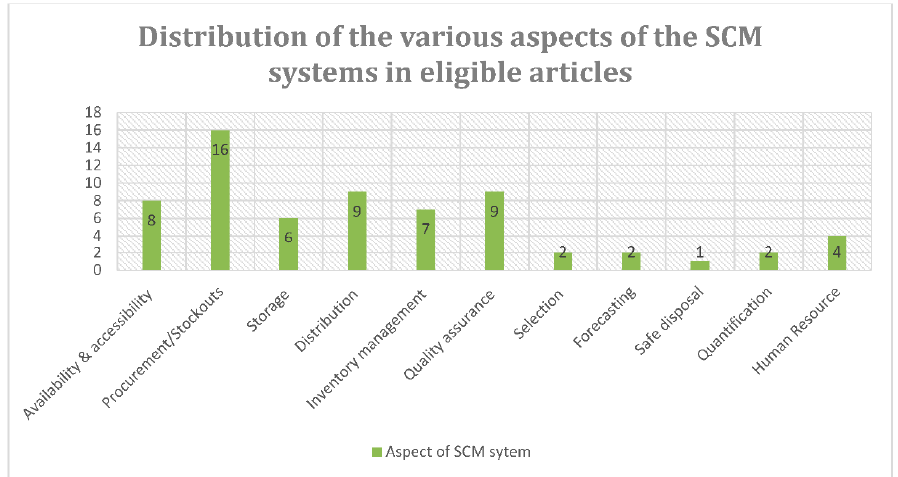
Figure 4. Aspects of supply chain management systems in the articles included in the scoping re- view on supply chain management systems for point-of-care diagnostic services.